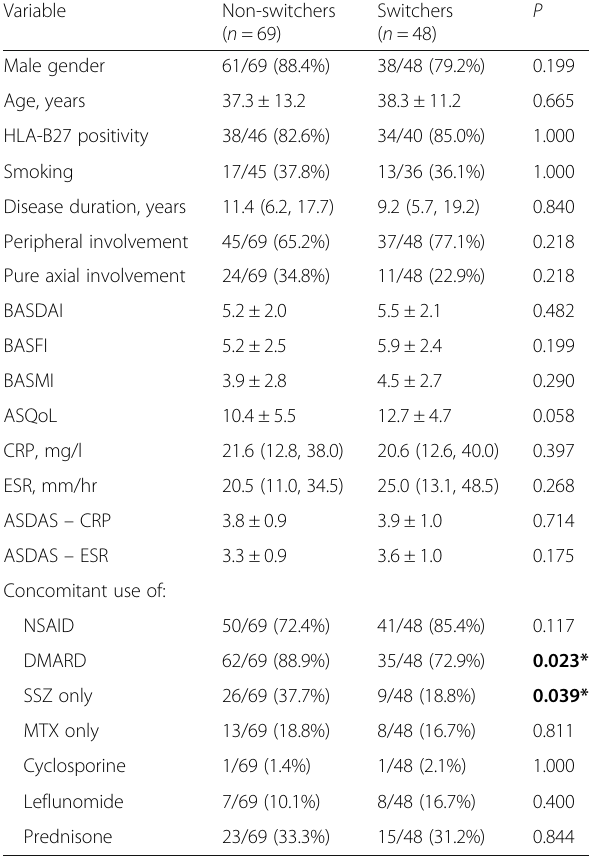
Table 2 Comparison at final evaluation between